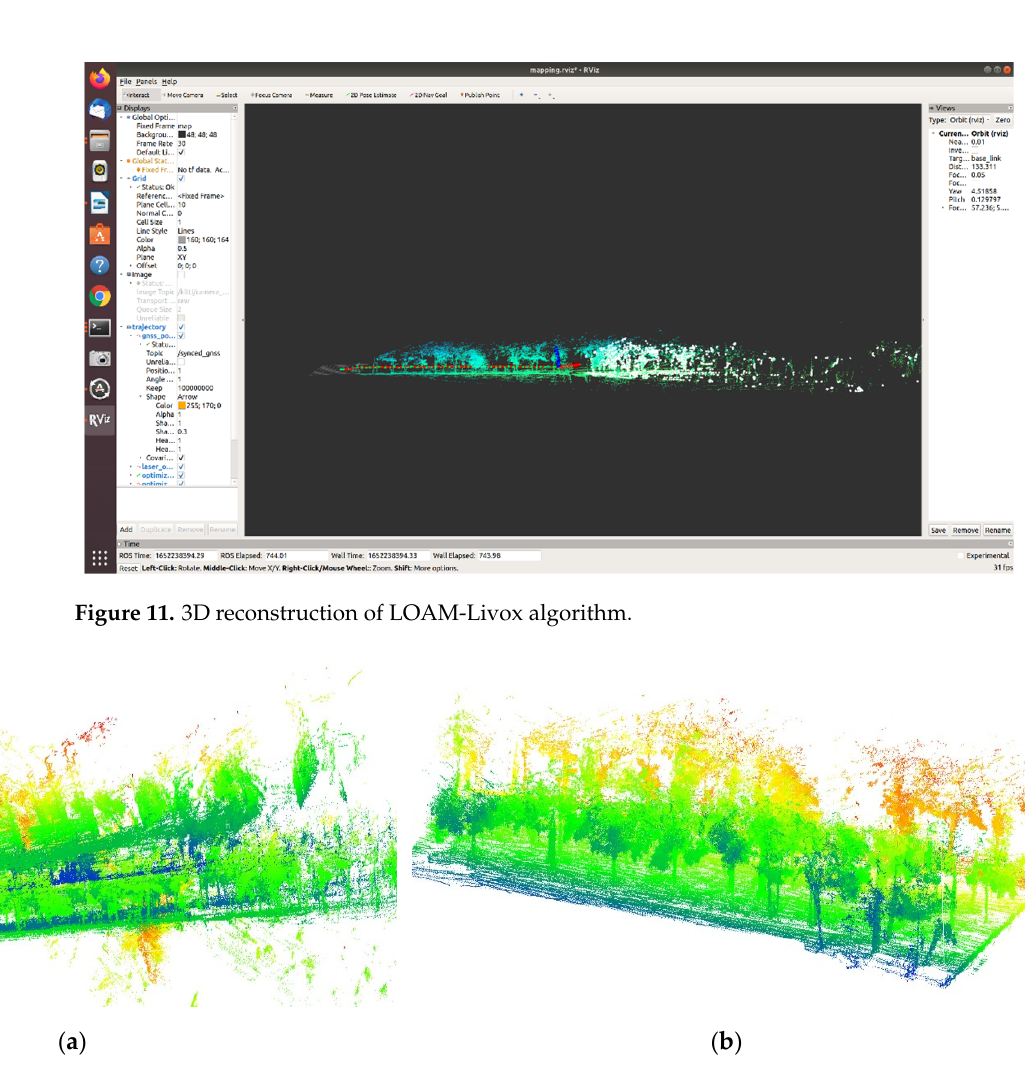
Figure 12. ICP algorithm point cloud registration diagram. (( a ) is before registration; ( b ) is after registration).